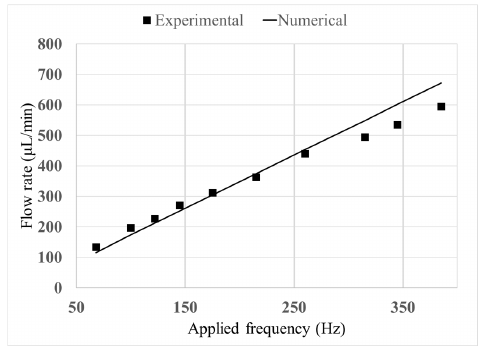
Figure 4. Comparison between experimental [30] and numerical results for the validation of the model.